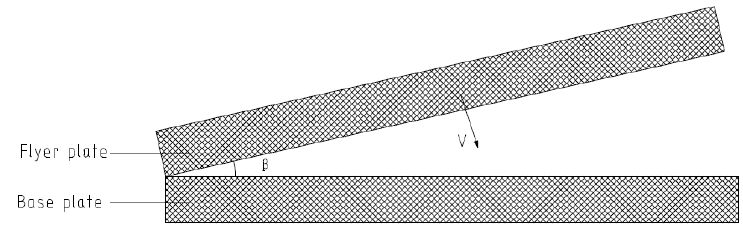
Figure 1. Schematic of the HVIW (high-velocity impact welding) model.